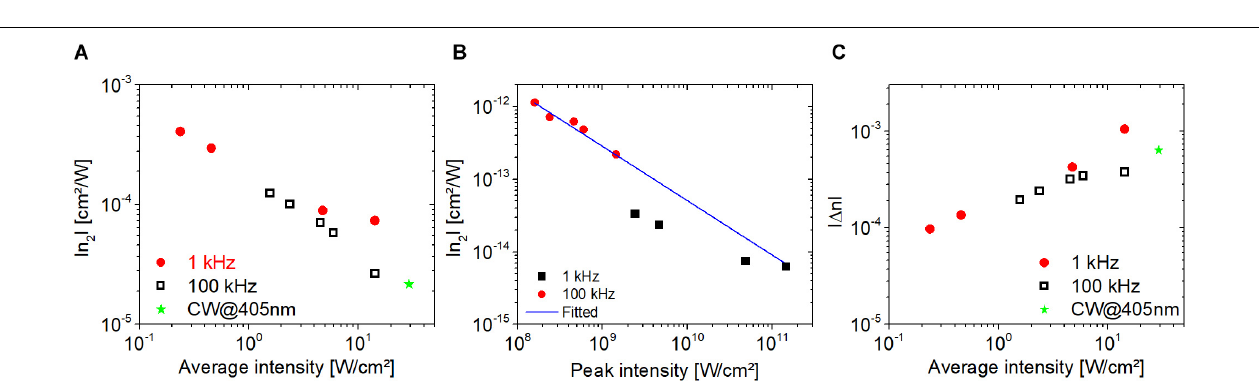
FIGURE 9 | Closed-aperture Z-scan traces measured on PYP using fs laser pulses at 514 nm at different excitation intensities at a repetition rate of (A) 1 kHz and (B) 100 kHz. (C) Comparison of the closed-aperture traces (filled symbols) and the open-aperture traces (hollow symbols) at a repetition rate of 1 kHz and 100 kHz, respectively, at ∼ 4.6-W/cm 2 excitation intensity.